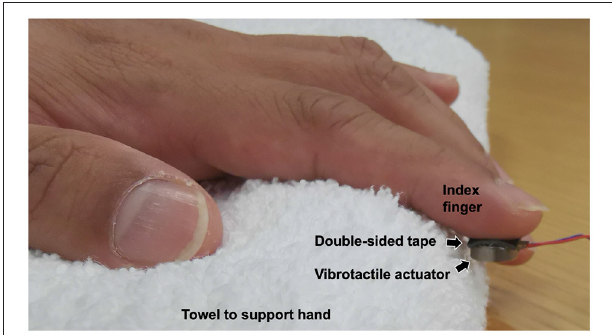
FIGURE 1 | Participant’s hand and a vibrotactile